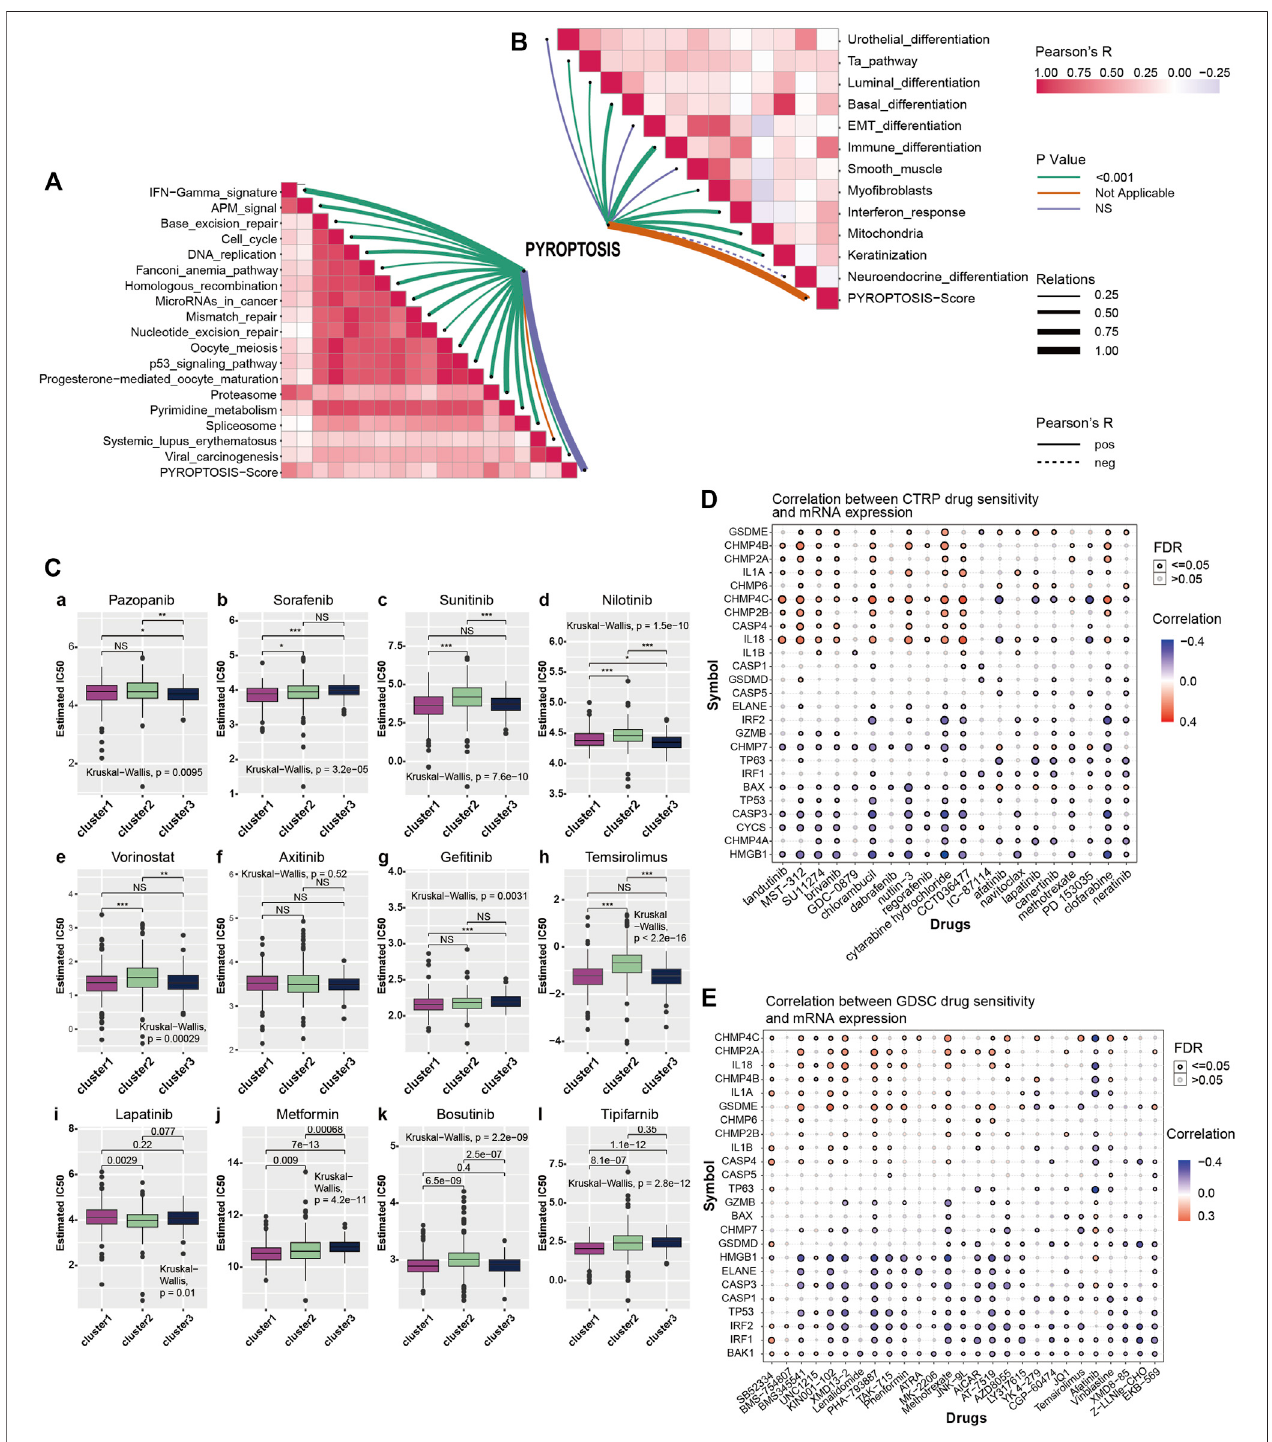
FIGURE 3 | (A) Correlation between pyroptosis-score and immunotherapy predicted pathways. The color bar on the right indicates Pearson R that the redder the color block is, the greater the correlation coef fi cient is, and the more purple the correlation coef fi cient is. The line color shows the p -value, with green representing p < 0.001, orange and violet representing not applicable and no statistical signi fi cance, respectively. Line thickness represents correlation coef fi cient, ranging from 0.25 to 1.00, the solid line represents positive correlation, the dotted line represents negative correlation. (B) Correlation between pyroptosis-score and signature gene pathway. (C) The box plots show the IC50 prediction of KIRC cells treated with a common tumor-targeted drug. (D) The heatmap shows the correlation between the sensitivity to drugs results in various cancers obtained from the CTRP database and the mRNA expression levels of pyroptosis-related genes. (E) The heatmap shows the correlation between the sensitivity of drugs results in various cancers obtained from the GDSC database and the mRNA expression levels of pyroptosis- related genes.